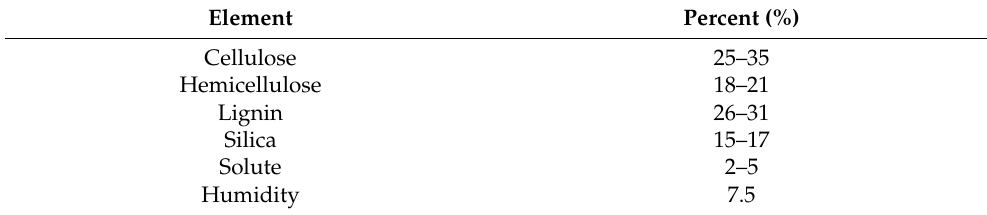
Table 5. Main rice husk (RH)